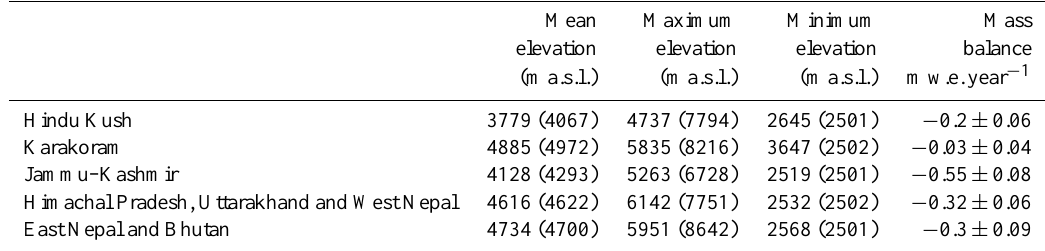
Table 1. Elevation statistics by region as used in the RCM at 25km resolution and derived from the GMTED2010 high-resolution elevation data set (in brackets) (Danielson and Gesch, 2011). Also shown are the satellite-derived glacier mass balance 2003–2009 from Kääb et al.